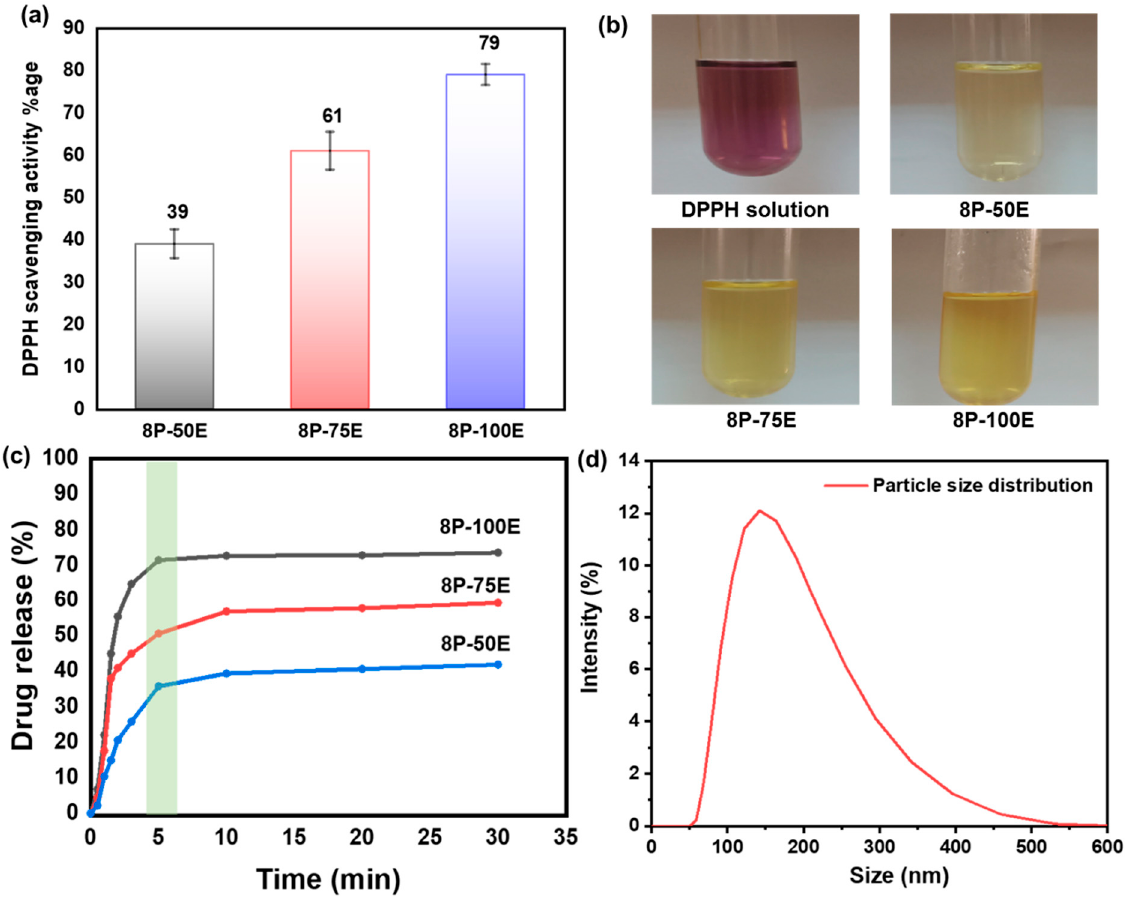
Figure 7. ( a , b ) DPPH free radical scavenging activity along with photographic results for the PVA nanofiber ( c ) drug release of the developed nanofibers sheet at different AI /water ratios 50:50, 75:25, and 100:0 with 8 wt%. PVA ( d ) AI particle size distribution released from the developed nanofibers membrane.